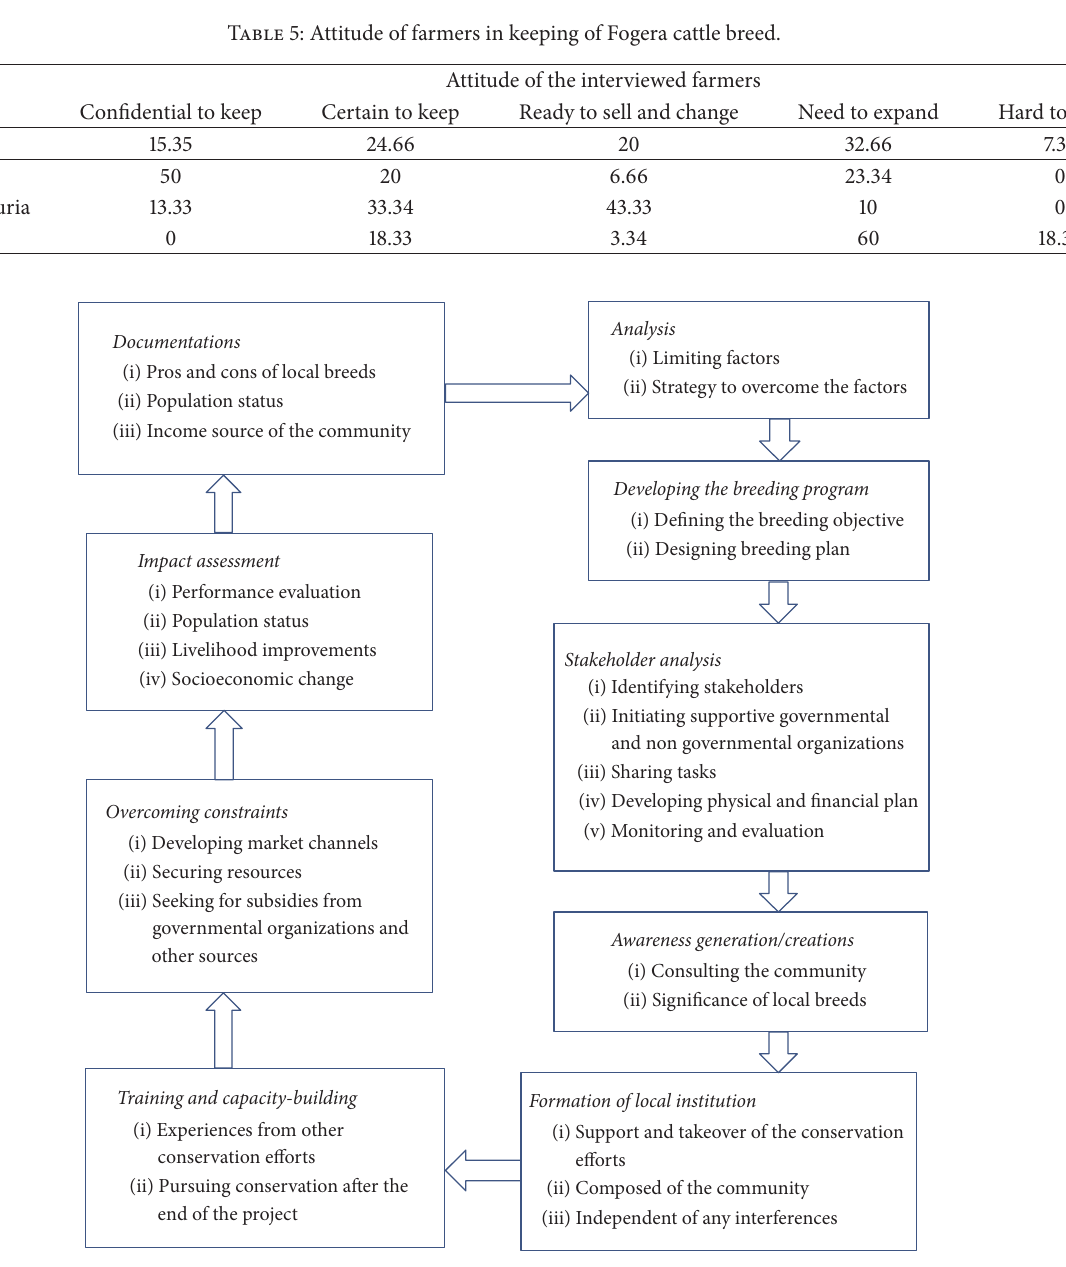
Figure 4: Steps for the implementation of community-based conservation program for local cattle breeds for sustainable rural